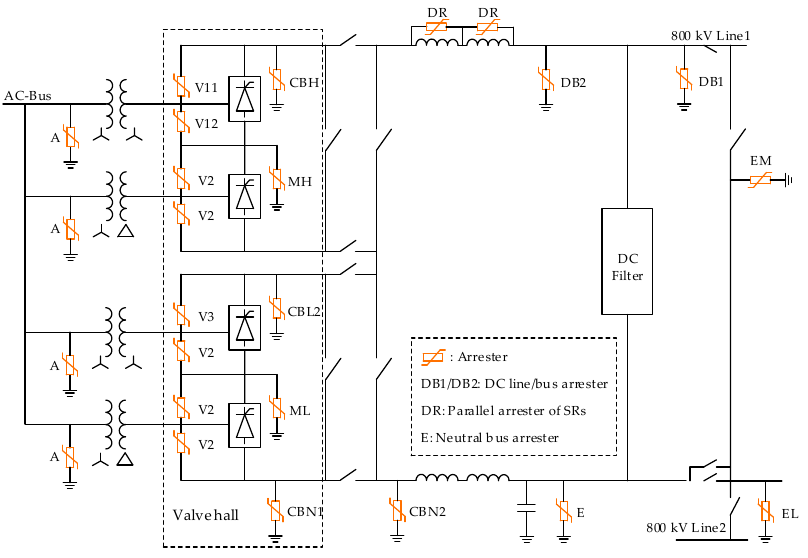
Figure 8. Arrester scheme of the studied project.